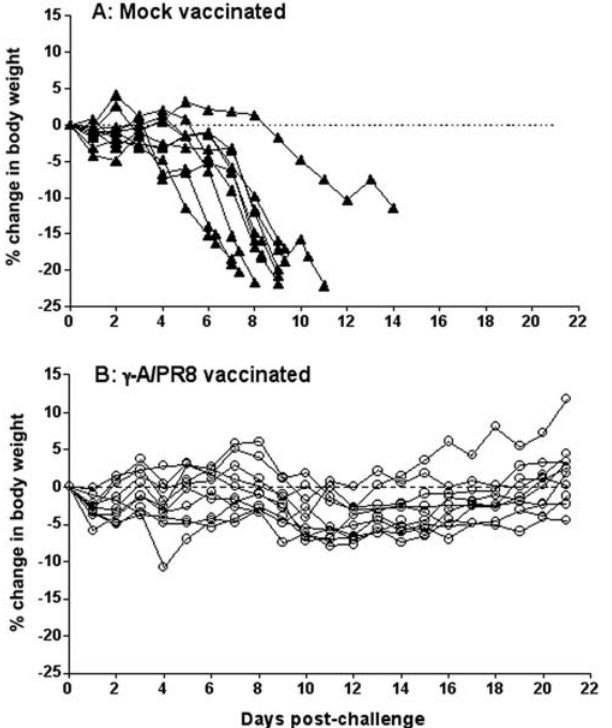
Table 1. H5N1 infectivity and viral genetic loads in lung and brain.